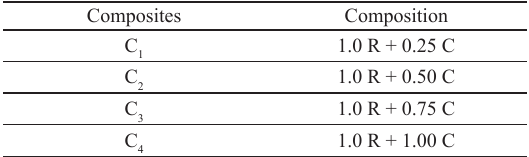
Table 1. Nomenclature used for each one of the composites.